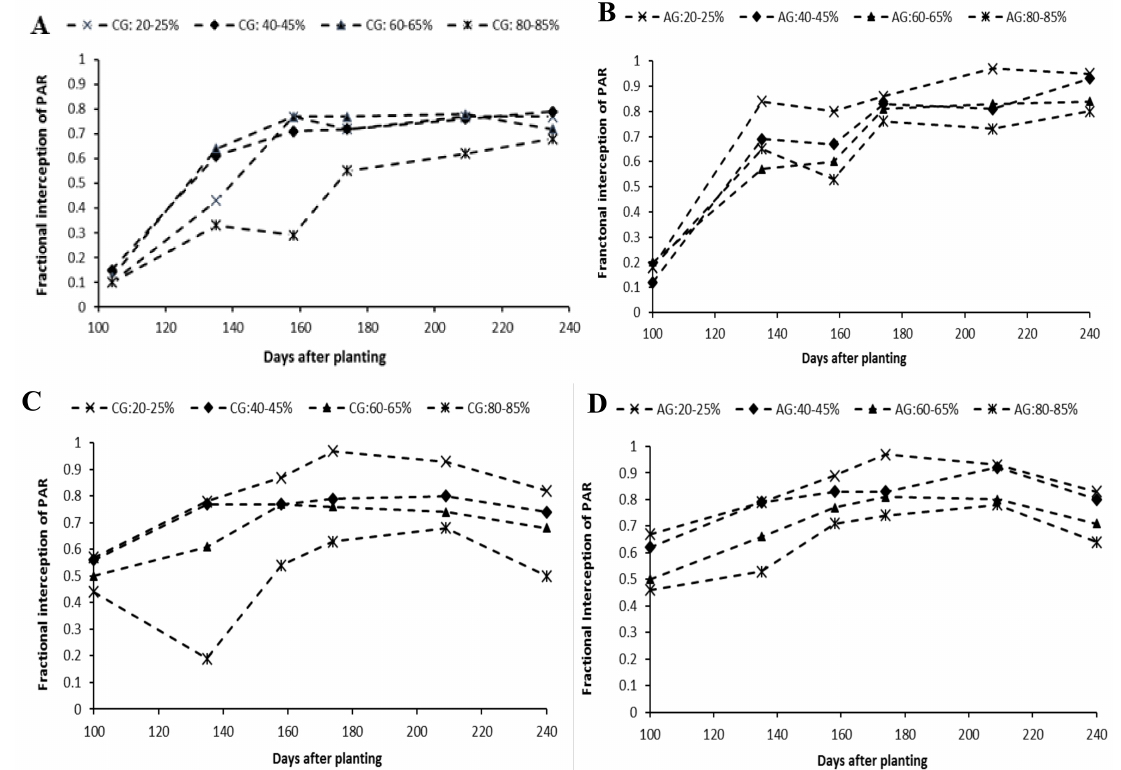
Figure 5. Fractional interception of photosynthetically active radiation (FI PAR ) of two ginger species in response to different water regimes during the ( A ) CG: 2015/2016, ( B ) AG: 2015/2016, ( C ) CG: 2016/2017; and, ( D ) AG: 2016/2017 cropping